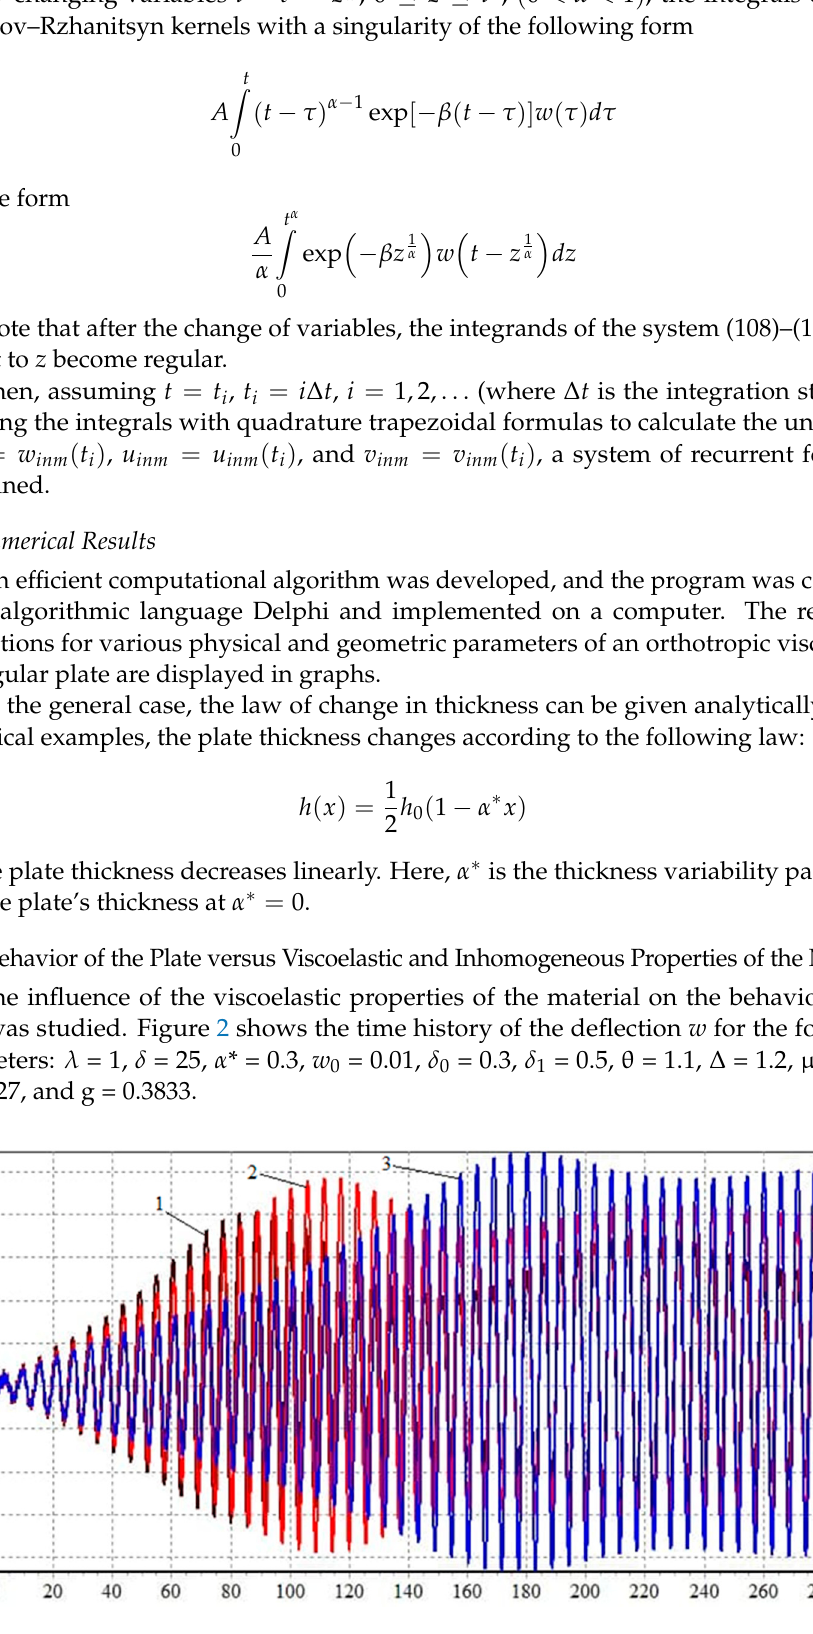
ij = 0.01, (2) A ij = 0.02, and (3) A ij =